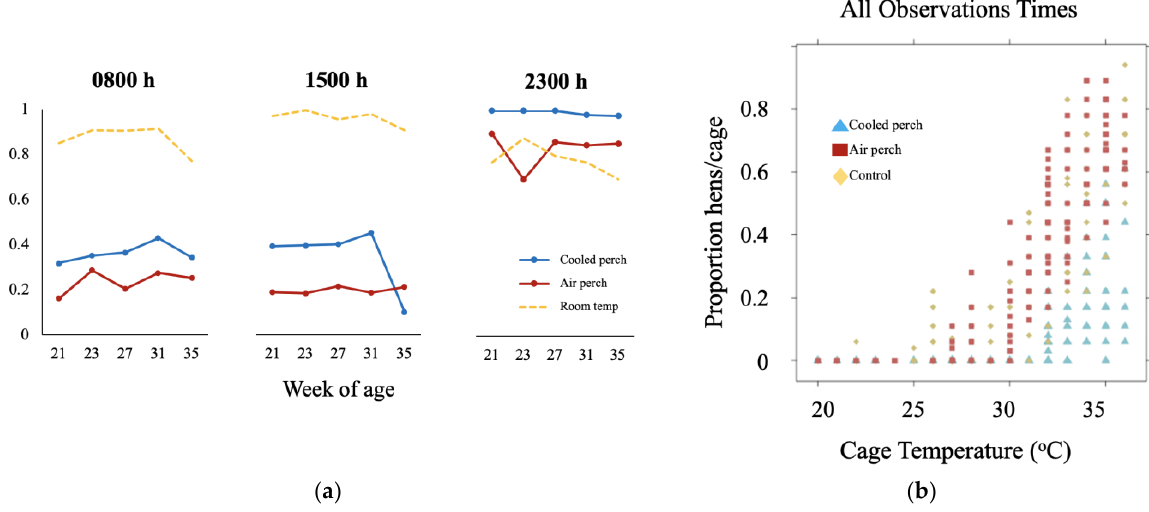
Figure 5. The effects of cooled perches on heat stressed-induced behaviors in caged laying hens from 21 to 35 wk of age. ( a ) perching behavior; and ( b ) proportion of hens per cage perching at different room temperatures.